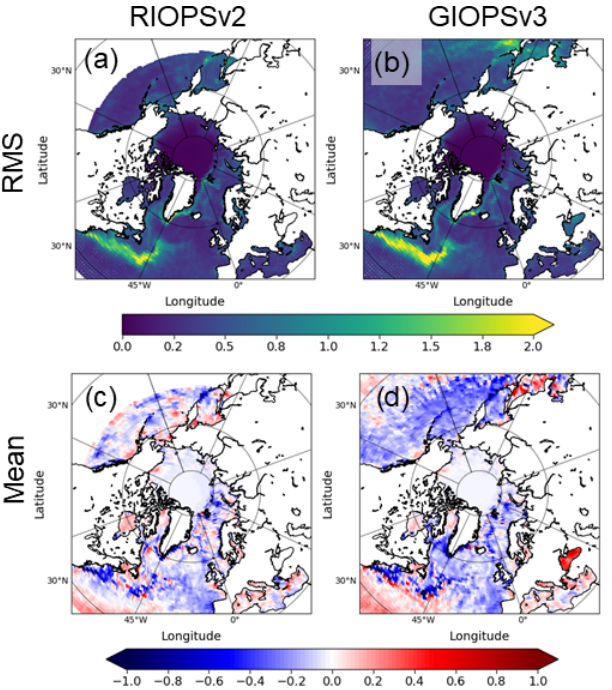
Figure 9. Innovation (observation–model) statistics of in situ tem- perature and salinity over the upper 500m depths for the period 1 January 2016 to 31 December 2018. The rms differences for tem- perature (a, b) and salinity (c, d) are shown for RIOPSv2 (a, c) and GIOPSv3 (b, d)